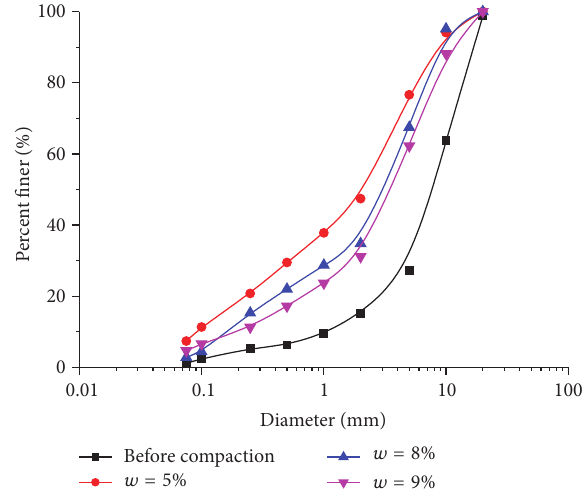
Figure5:Particlesizegradingofcrushedred-bedsoftrockmixtures before and after